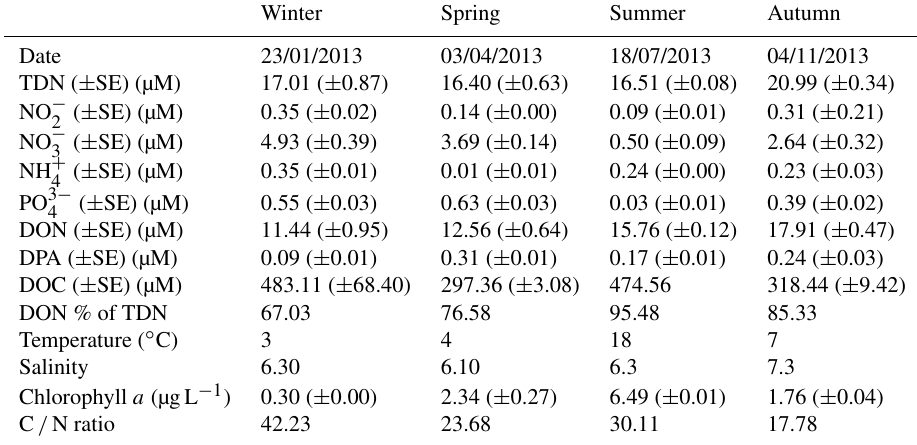
Table 1. Physicochemical parameters in coastal seawater for the different sampled seasons. Standard errors (SE) are derived from duplicate sample analysis. C:N ratio is calculated as the ratio DOC:DON (moles).